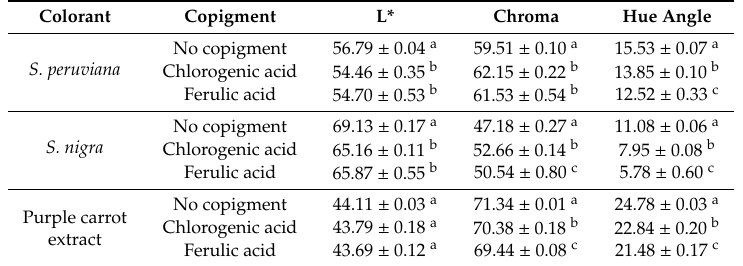
Table 1. Initial color characteristics of model beverages colored with S. peruviana , S. nigra , and purple carrot extract with and without chlorogenic and ferulic acids as